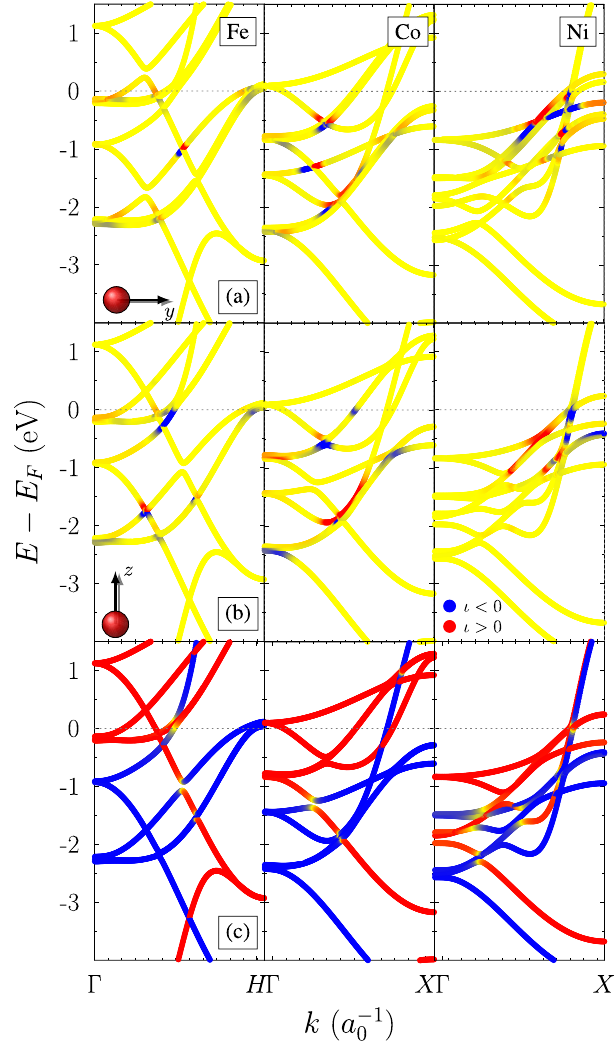
Figure 4. Moment of inertia in the electron band structure for bulk bcc Fe, fcc Co, and fcc Ni with the magnetic moment ( a ) in y direction and ( b ) in z direction. The colour and the intensity indicates the sign and value of the inertia contribution (blue: ι < 0; red: ι > 0; yellow: ι ≈ 0 ). The dotted grey line is the Fermi energy and Γ is 0.1 eV. ( c ) Spin polarisation of the electronic band structure (blue - spin down; red - spin up; yellow - mixed states). Note that we analyse for simplicity and clarity only one contribution, A n B m , in the expression for V nm